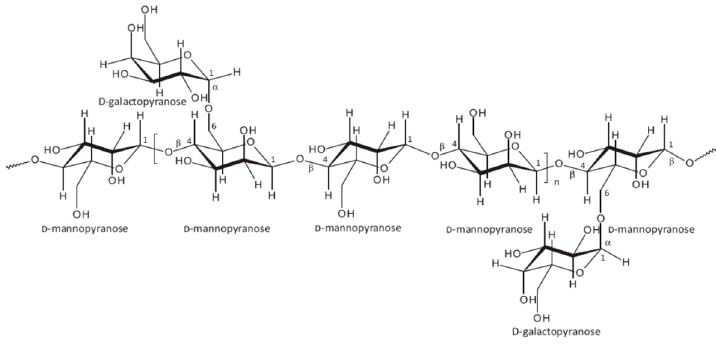
Figure 2. Chemical structure of Caesalpinia spinosa gum.